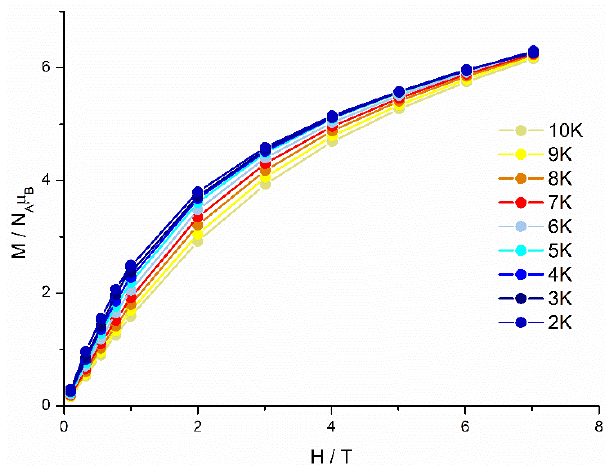
Figure 4 . M vs. H plots for complex 2 in various temperatures as indicated. Solid lines are guidelines Figure 4. ( a ) Temperature dependence of magnetic susceptibility for complexes 1 , 2 , and 3 . Green solid for the eyes. line represents simulation of the data in complexes 1 and 3 ; see text for details and fitting